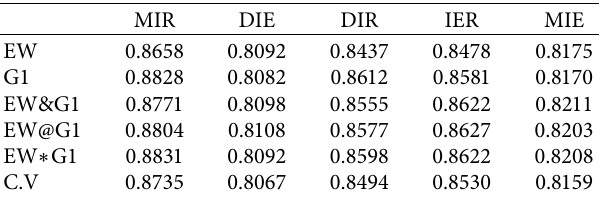
Figure 6: Comparative experiment of apple data set. Table 4: Apple data set.